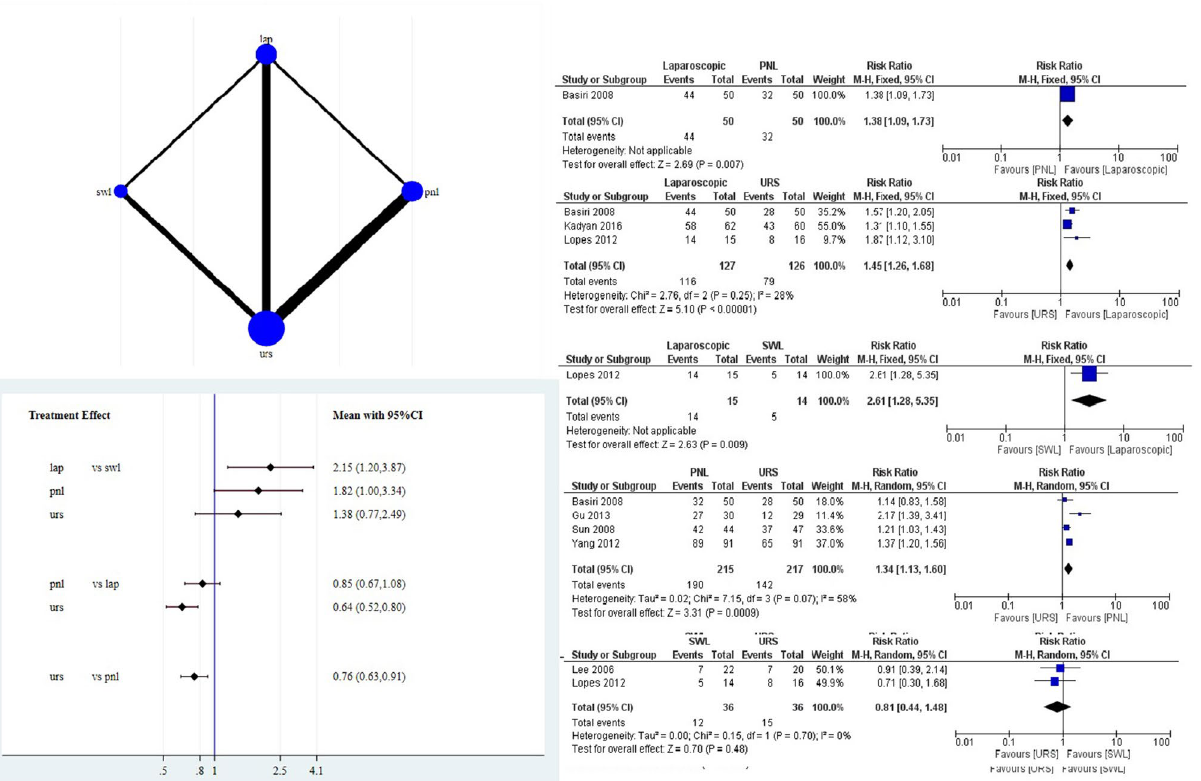
Figure 2. Depicts network map, interval plot and Forest plot for the initial stone free